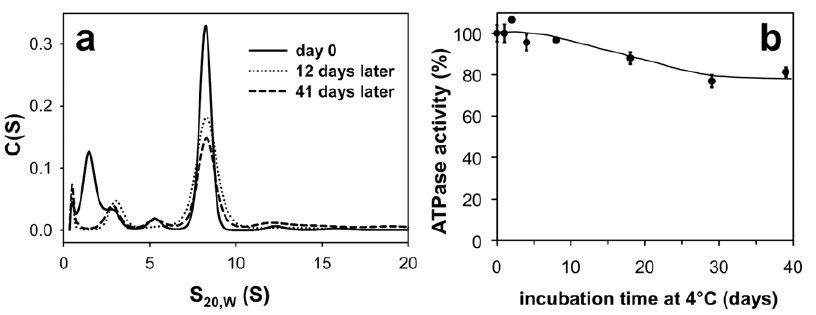
Figure 3. Stability of DDM-purified BmrC/BmrD. ( a ) After nickel-affinity and size-exclusion chromatography in the presence of DDM, purified BmrC/BmrD protein at 0.11 mg/ml was immediately subjected (day 0) to sedimentation velocity measurements or incubated at 4 u C for 12 or 41 days before performing analytical ultracentrifugation experiments at 42000 rpm and 20 u C. The superposition of the c ( s ) curves from data obtained at 278 nm at different times is shown. ( b ) ATPase activity of nickel-affinity purified BmrC/BmrD was determined in 0.05% (w/v) DDM after incubation at 4 u C for the indicated times. The values are expressed as the mean 6 SD for three measurements, relative to the ATPase activity obtained without prior incubation at 4 u C (244 6 10 nmol ? min 2 1 ? mg 2 1 ).